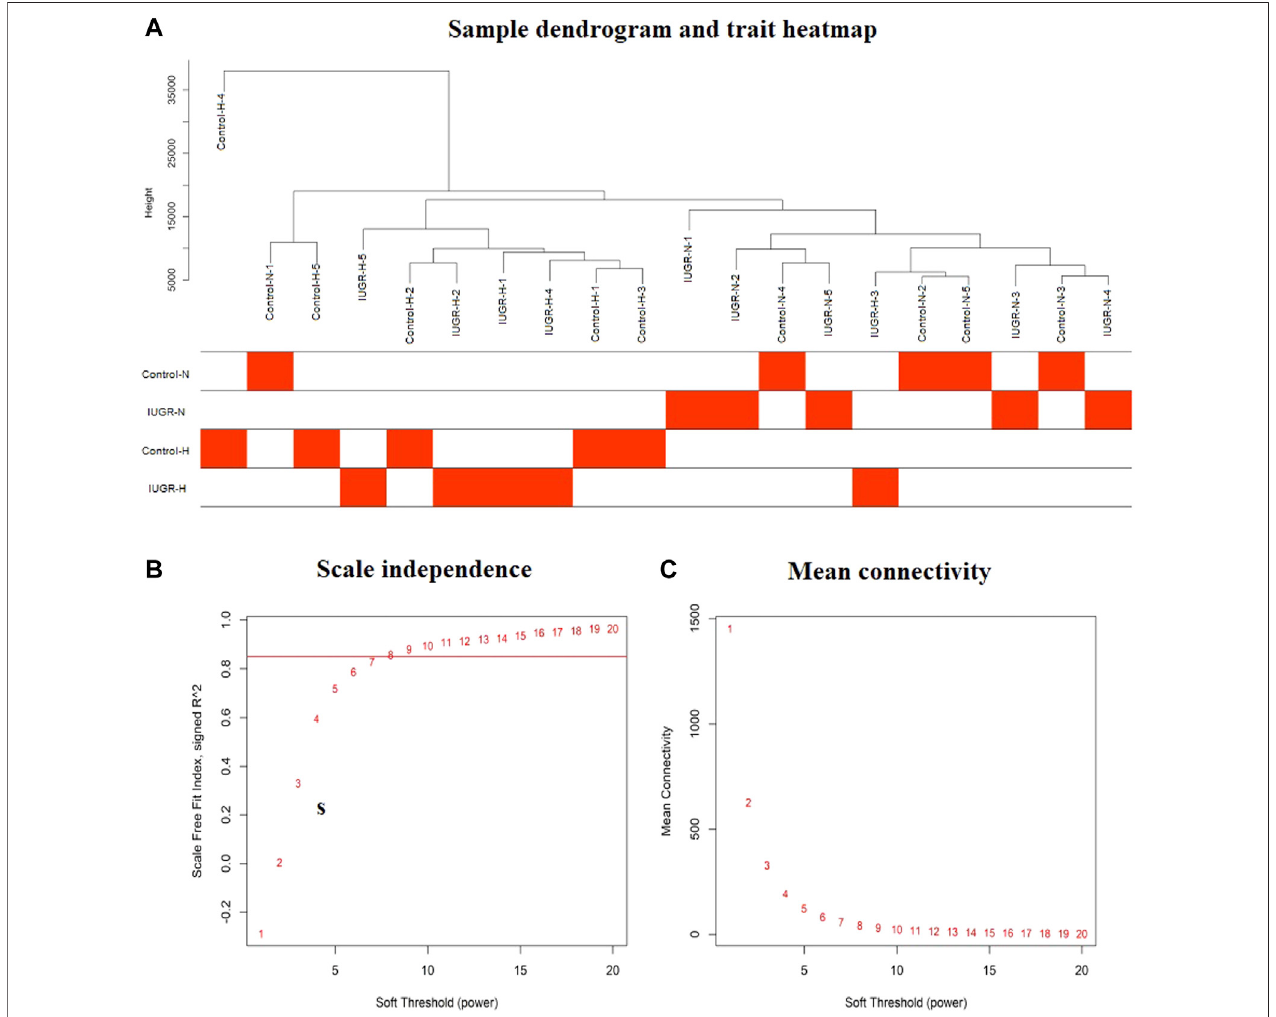
FIGURE 2 | Sample dendrogram and trait heatmap, and the estimation of soft thresholding values ( β ). (A) Sample cluster dendrogram and clinical trait heatmap of 20 liver samples based on their expression pro fi le: fi ve control-normoxia (Control-N), fi ve IUGR-normoxia (IUGR-N), fi ve control-hypoxia (Control-H), and fi ve IUGR- hypoxia (IUGR-H). (B) Analysis of the scale-free fi t index for various soft thresholding powers ( β ). (C) Analysis of mean connectivity of various soft thresholding powers.